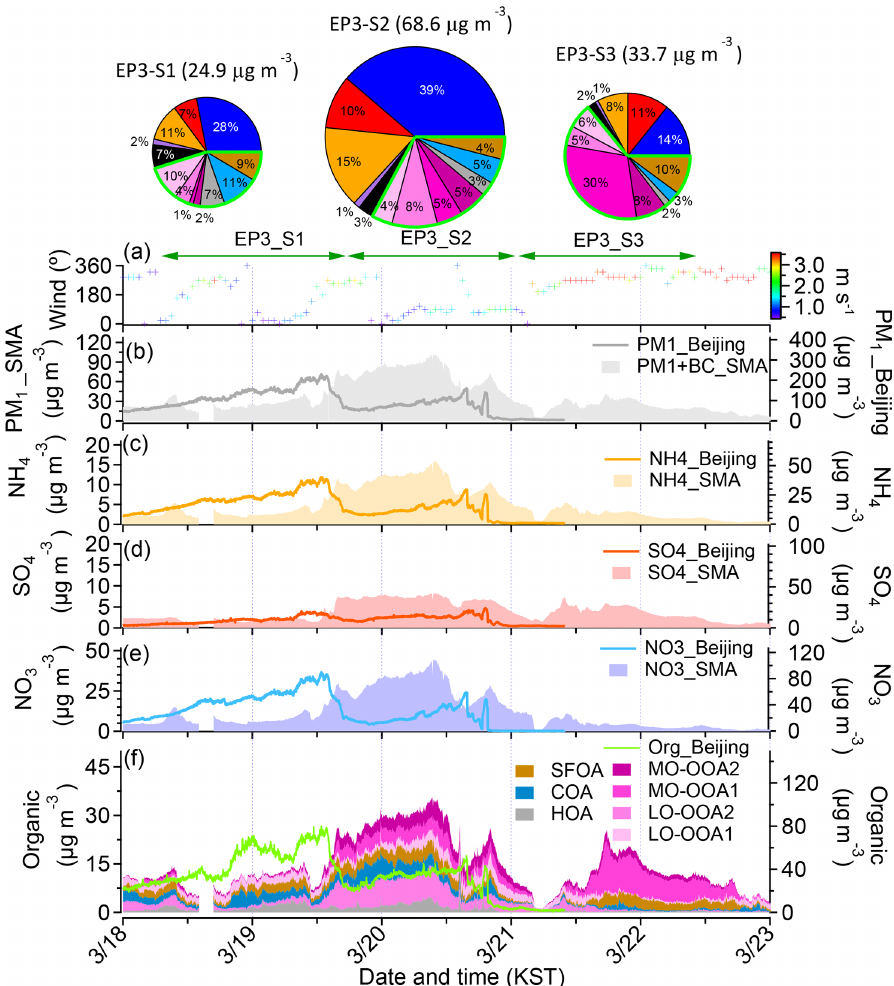
Figure 6. Overview of the chemical composition of the submicron aerosols at the Korea Institute of Science and Technology (KIST) in the SMA and Beijing from 18 to 23 March 2019, including one haze episode: (a) time series of the wind direction (WD), with the colors showing the different wind speeds (WSs) in the SMA; (b) time series of PM 1 + BC in the SMA and of PM 1 in Beijing; (c) time series of ammonium (NH + ) in the SMA and Beijing; (d) time series of sulfate (SO 4 ) in the SMA and Beijing; (e) time series of nitrate (NO − 4 Beijing; (f) time series of the organic and stacked contributions of the sources of the OA in the SMA and Beijing. Note that the time series of each species in Beijing is modified to KST from Beijing